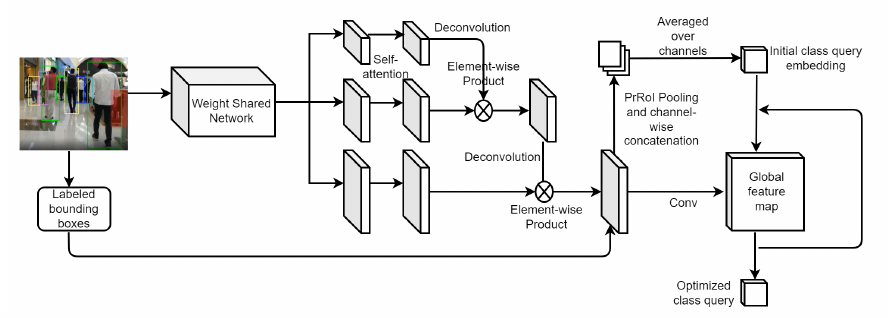
Figure 3. Generation of optimized class query. The combined feature map of whole image is used to extract the initial target model and iteratively optimize the query